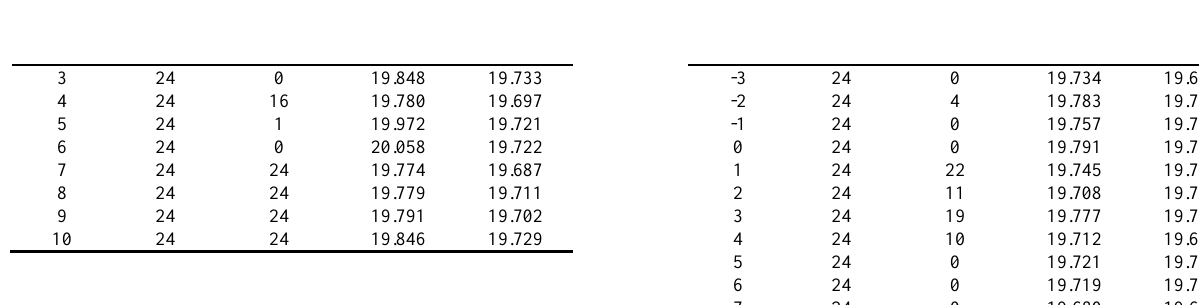
Table 18. Results under Scenario 2c .